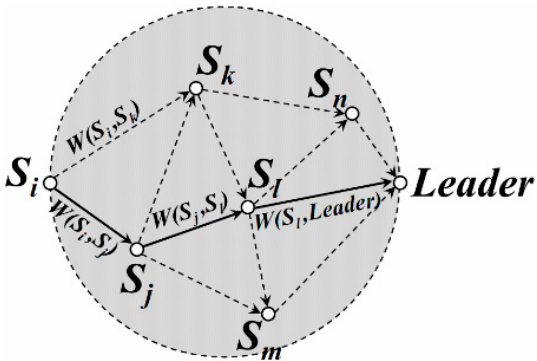
Figure 11. Weighted directed graph for data uploading.